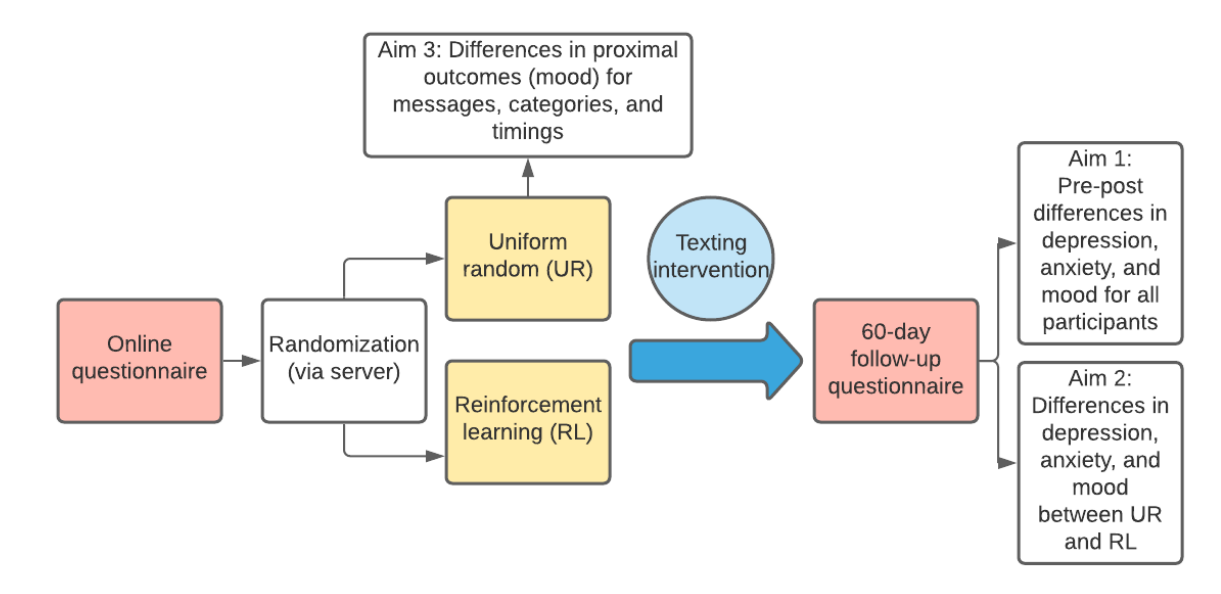
Figure 1. StayWell at Home study